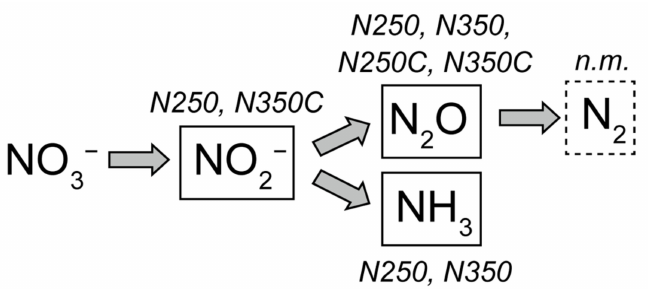
Figure 8. Model of abiotic nitrate reduction processes. Nitrite and nitrous oxide were detected as intermediate products during abiotic nitrate reduction in the komatiite–H 2 O–NO 3 − and H 2 O–NO 3 − systems. By contrast, ammonia was detected as an end product of abiotic nitrate reduction in the komatiite–H 2 O–NO 3– system (“chemoammonification”), but not in the H 2 O–NO 3 − system. N 2 is thought to be another end product of abiotic nitrate reduction via nitrous oxide (“chemodenitrifica- tion”). Nitrogen species detected by experiments are shown in square. Experiment IDs in which a given nitrogen species was detected are shown. The fact that nitrite remained undetected in